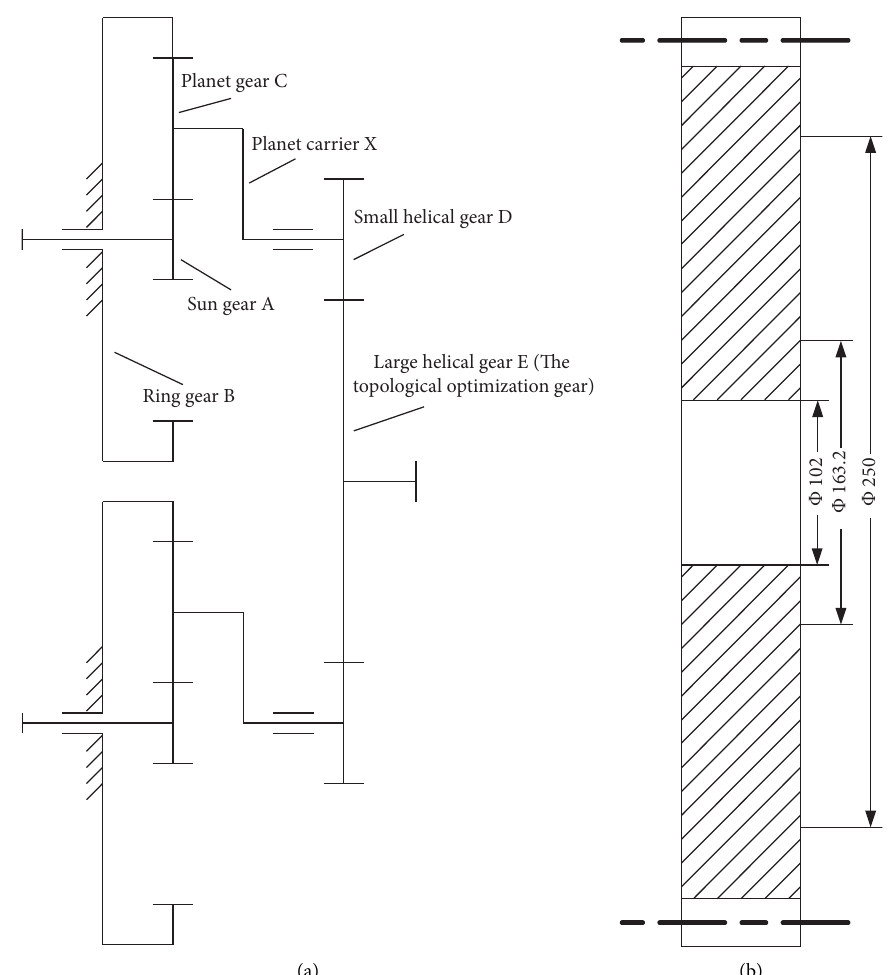
Figure 2: Schematic of the rotary transmission system. (a) Schematic of the transmission system. (b) Structure schematic of the large helical gear.